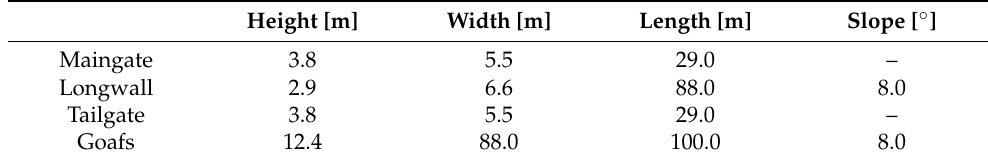
Table 1. Dimensions of the numerical model geometry.